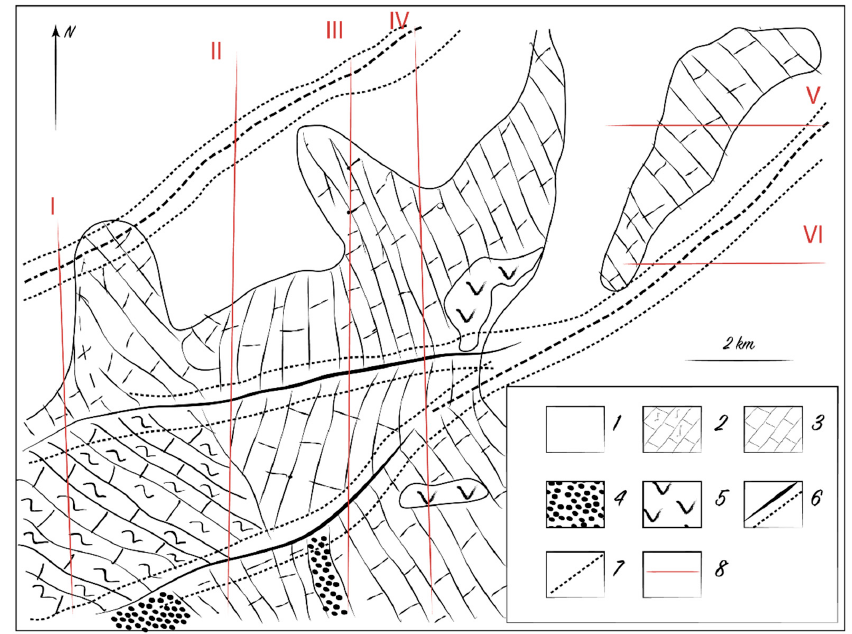
Figure 6. Biogeochemical anomalies over the disjunctive faults at the Telmanskoe ore field, Dzun- garian Alatau. Symbols: 1—loose deposits, 20 m thick; 2—calcareous clayey shales; 3—limestones; 4—dolomites; 5—diorite porphyrites; 6—confirmed disjunctive faults; 7—presumable disjunctive faults; 8—biogeochemical Pb–Zn anomalies; 9—sampling transect lines and their numbers. The roman numerals (I–VI) show the transect numbers.